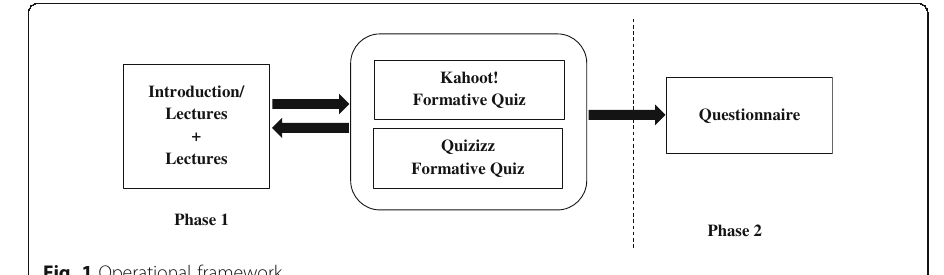
Fig. 1 Operational framework